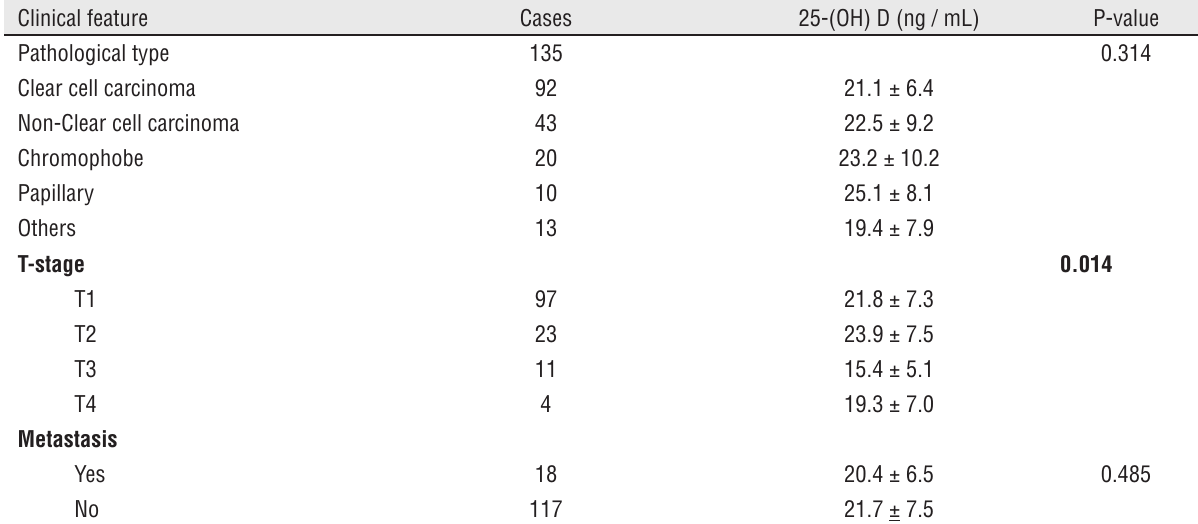
Table 2 - The Circulating 25-(OH) D levels of renal cell carcinoma cases according to clinical features.